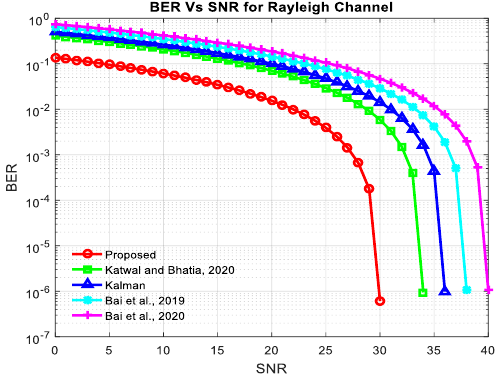
Figure 11. BER vs. SNR analysis for a Rayleigh channel